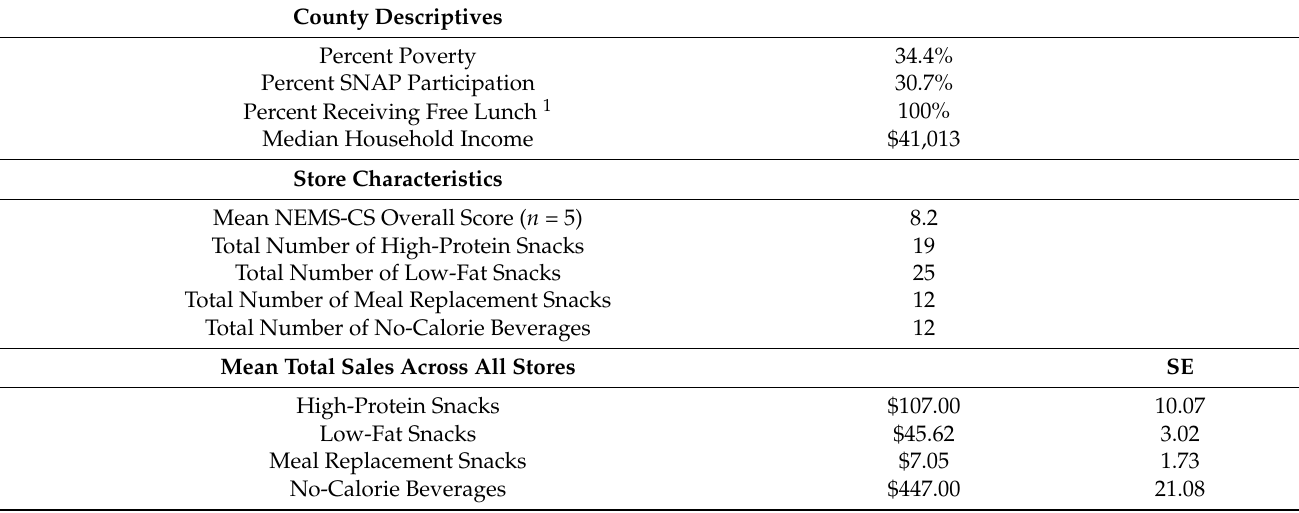
Table 1. County Level descriptives and store characteristics across all time periods, Martin County, KY,